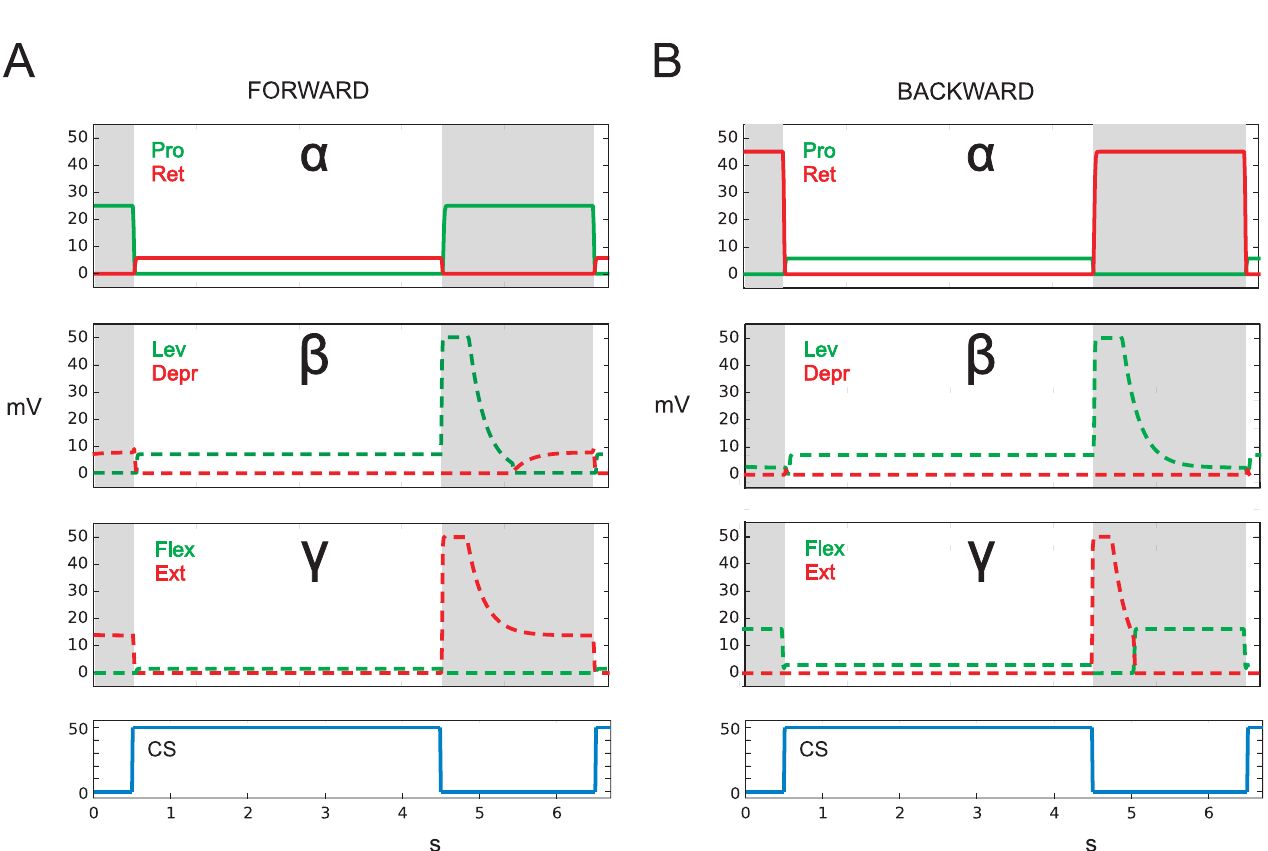
Fig 2. CS stimulus drives (via caudal bending of femur) protractor or retractor as observed in [20]. Caudal bending, i.e., activation of CS stimulus (below, blue) activates state Stance (highlighted white region), caudal relaxation activates Swing (highlighted grey). A) state: Forward walking, B) state: Backward walking. Abscissa: time (s), ordinate (mV). Dashed lines: simulation data for which no biological results are given. The three output channels are marked by the joints alpha, beta, and gamma.